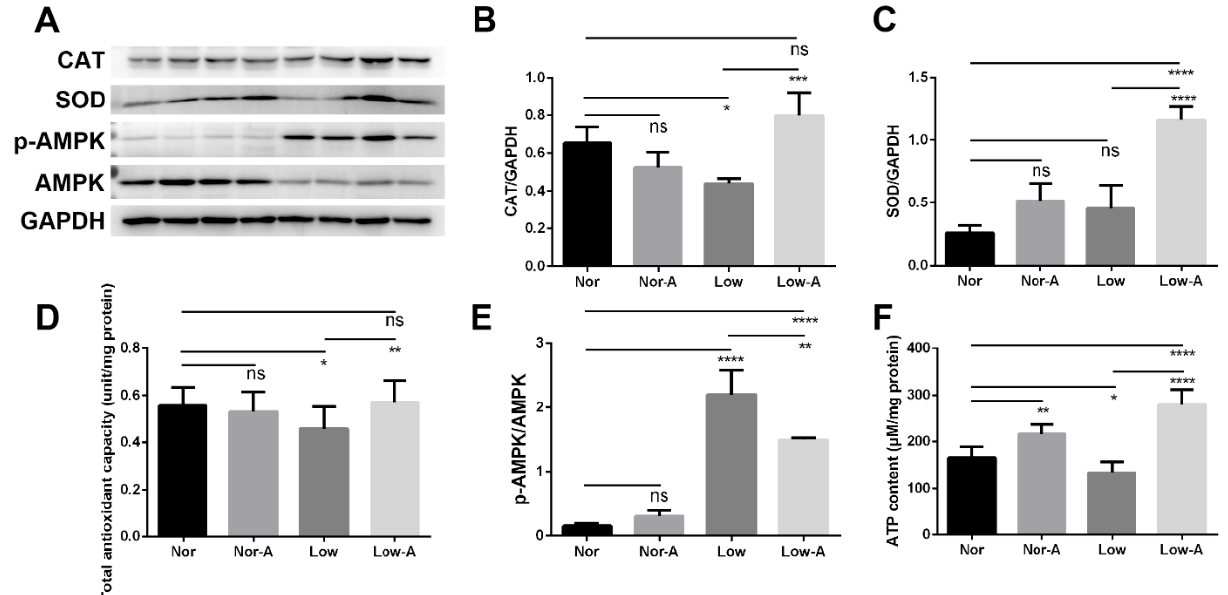
Figure 7. Antioxidant capacities and energy states of the four groups of C2C12 myoblasts. ( A ) Western blot analyses of antioxidant-related proteins in myoblasts. The anti-GAPDH antibody was used to standardize the amount of protein in each lane. ( B ) Expressions of the catalase (CAT) protein; ( C ) Expressions of the superoxide dismutase (SOD) protein; ( D ) Total antioxidant capacities; ( E ) Ratios of p-AMPK/AMPK; ( F ) ATP content. * p < 0.05, ** p < 0.01, *** p < 0.001, **** p < 0.0001. n = 4 for each group.